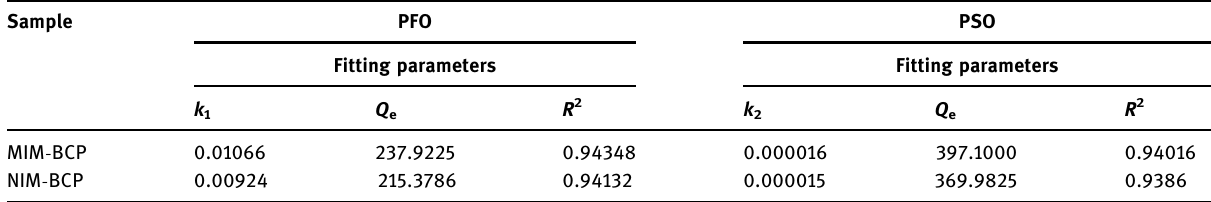
Table 1: Parameters obtained for PFO and PSO models